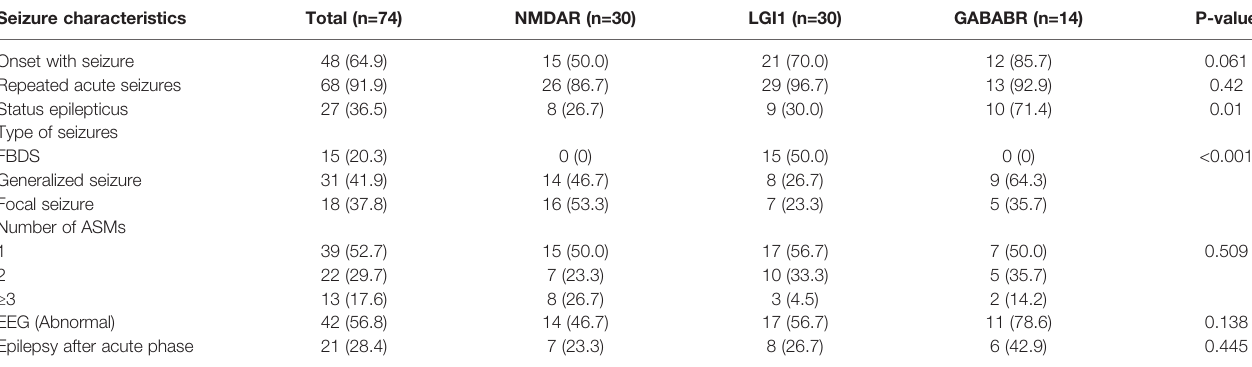
TABLE 2 | Seizure characteristics by type of AE.